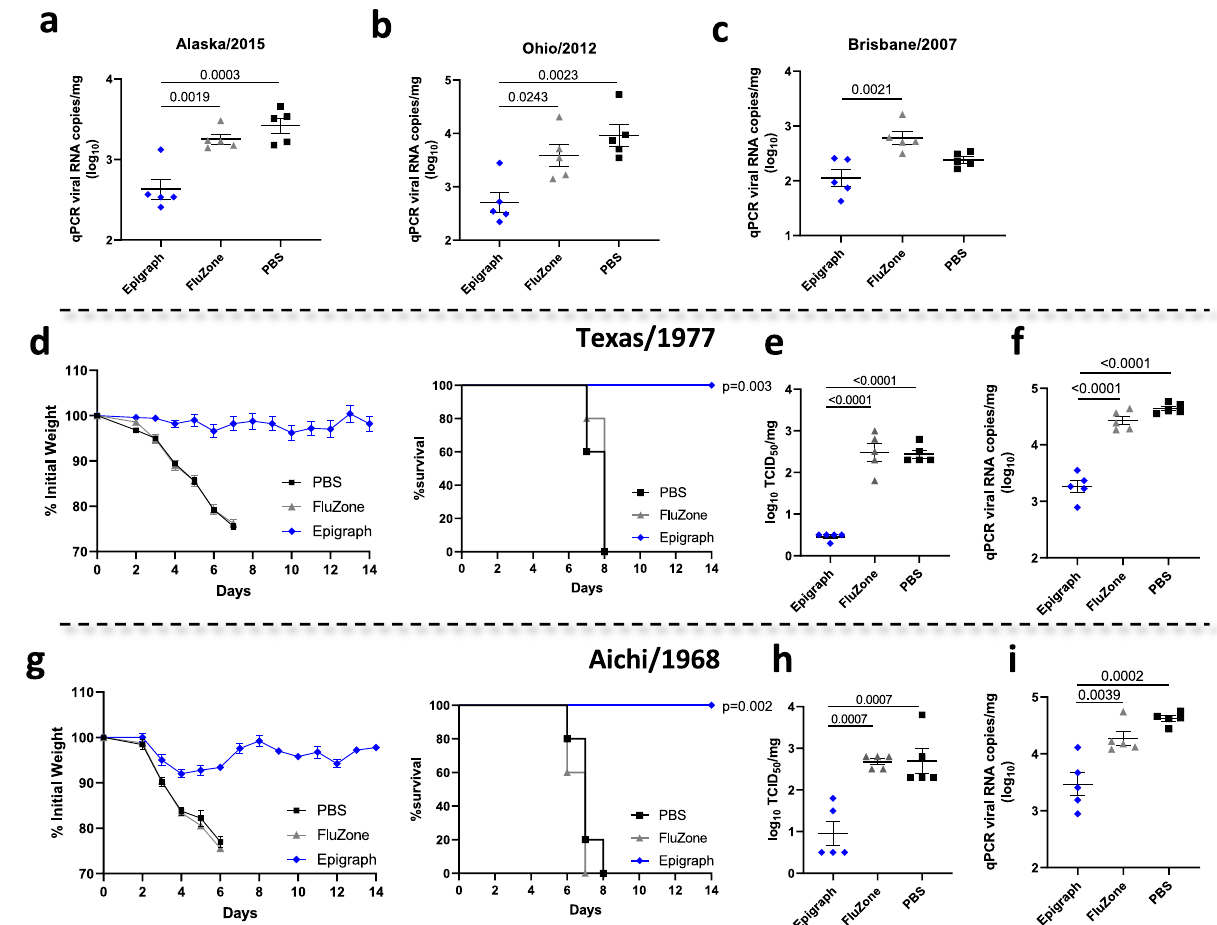
Fig. 4 Protection against challenge with contemporary and historical H3 viruses in mice. BALB/c mice were vaccinated with 10 10 vp of HAdV-5-Epigraph, the FluZone vaccine, or a mock PBS vaccine. Mice were challenged intranasally three weeks after immunization with 10 3.6 – 3.8 TCID 50 of contemporary strains Alaska/2015 ( a ), Ohio/2012 ( b ), or Brisbane/2007 ( c ) and sacri fi ced 3 days post challenge to examine lung viral titers ( n = 5; one-way ANOVA with Tukey multiple comparisons). For lethal challenge with historical H3 strains, BALB/c mice ( n = 10) were challenged intranasally 3 weeks post immunization with 10 MLD 50 of Texas/1977 ( d – f ) or Aichi/1968 ( g – i ). Mice were monitored for weight loss over 14 days and animals that showed 25% weight loss were humanely euthanized ( n = 5; Kaplan – Meier log-rank test compared to the sham vaccinated group). Weight loss data are censored after the fi rst animal death in a group to prevent survival bias. Three days post infection, fi ve mice per group were sacri fi ced to examine lung viral titers by TCID 50 ( e , h ) and qPCR ( f , i ) ( n = 5; one-way ANOVA with Tukey multiple comparison). Data are presented as the mean with standard error